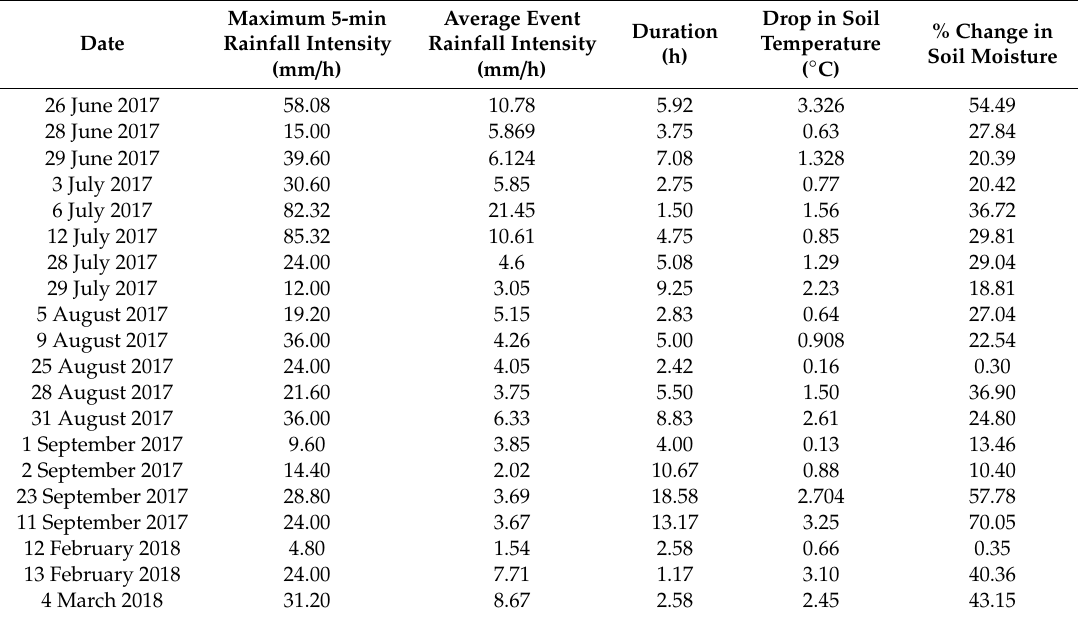
Table 1. Characteristics of selected rainfall events with corresponding changes in soil temperature and moisture in GA